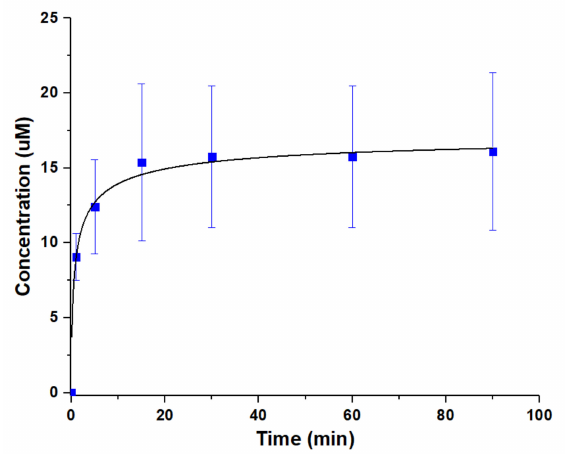
Figure 5. Release profile from the material for tetracycline in physiological sodium chloride at room temperature. Error bars are standard